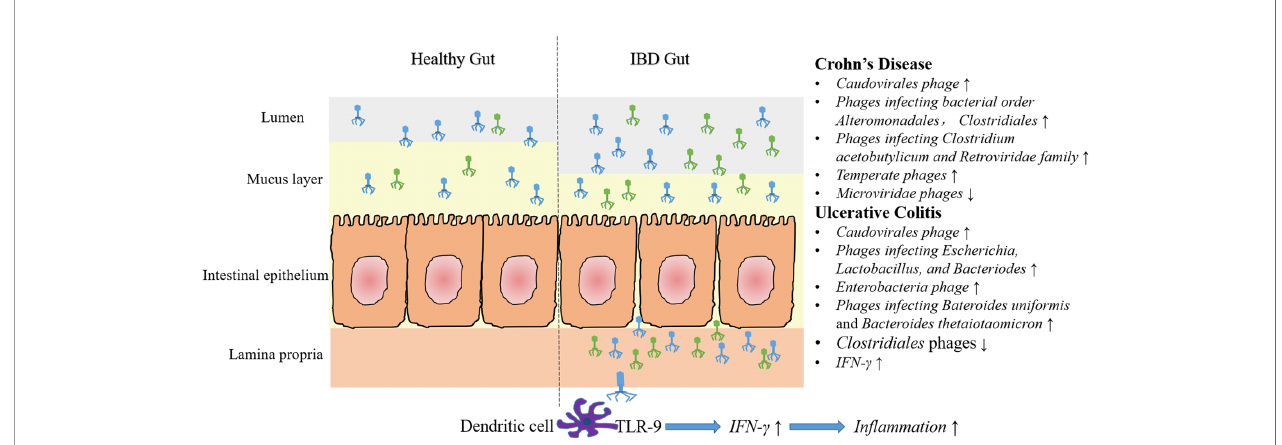
FIGURE 1 | Characteristics of gut phage community and phage associated immune modulation in IBD. Compared with healthy gut, more caudovirales phages are found in the intestinal lumen and mucus layer. Moreover, some speci fi c phage community changes have been demonstrated in CD and UC. In CD, an increased abundance of temperate phages and phages infecting bacterial order Alteromonadales , Clostridiales , Retroviridae family and Clostridium acetobutylicum , and a decreased abundance of Microviridae phages have been reported. In UC, numbers of phages infecting Escherichia , Lactobacillus and Bacteriodes (e.g., Bacteroides uniformis and Bacteroides thetaiotaomicron ) and Enterobacteria phages increased, whereas Clostridiales phages decreased. It should be noted, however, some of the above results are just concluded from a single experiment, and that can ’ t be compared with each other, due to different samples and methods are used. Additionally, impaired epithelial barrier in IBD lead to increased intestinal permeability, that lead to the migration of many phage particles into the lamina propria or even the circulation. In vitro experiments showed that recognition of phage DNA via TLR9 on dendritic cells stimulated the production of IFN- g , thereby aggravated intestinal in fl